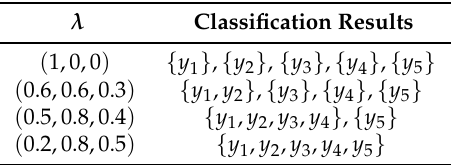
Table 3. Clustering algorithm in literature [28].